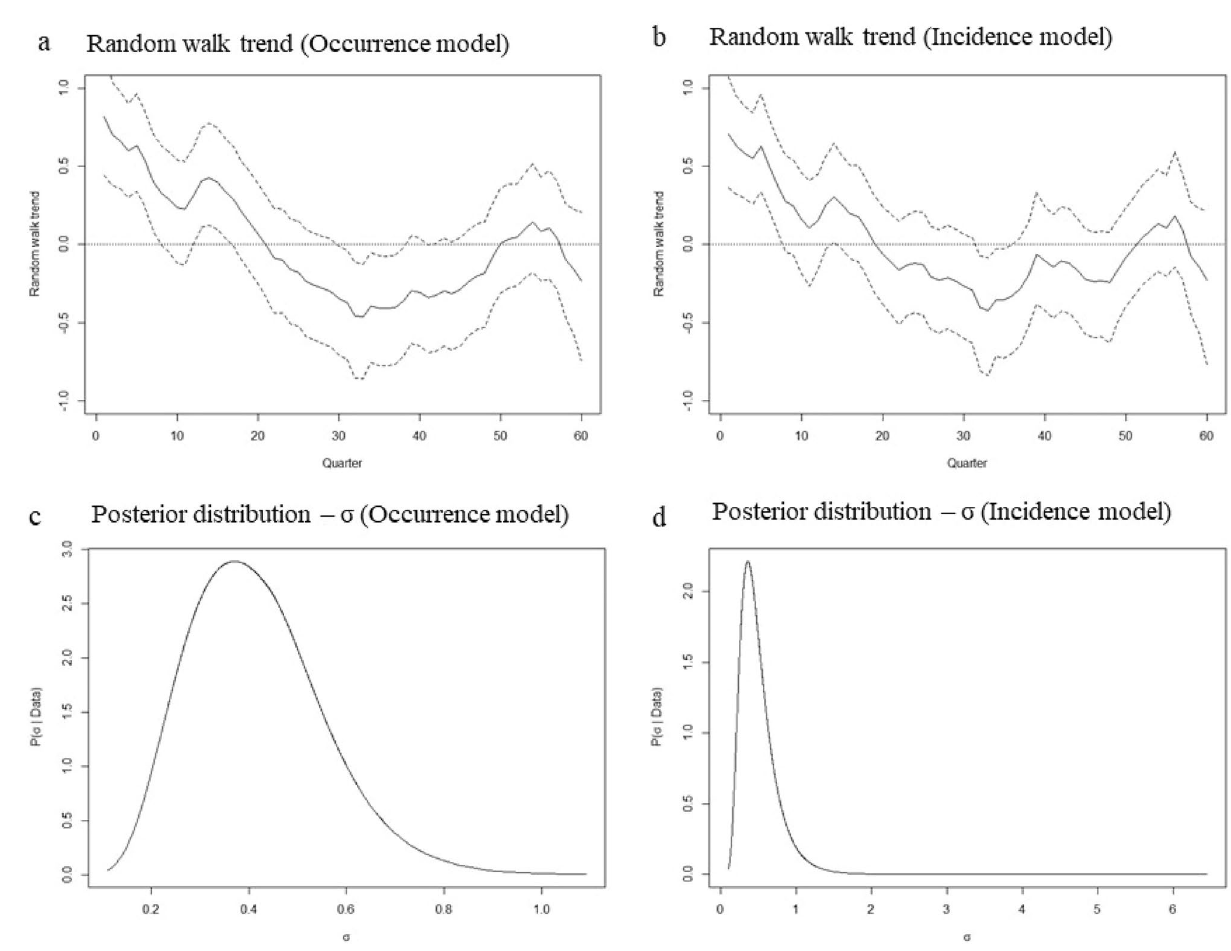
Figure 13. Random walk trend for the occurrence ( a ) and incidence ( b ) models. The lower panels show the marginal posterior distribution for the standard deviation (σ) hyperparameter of the random walk trend for the occurrence model ( c ) and the incidence model ( d ). The image was derived from the results of the R-INLA package 20 implemented via R v. 4.1.0 28